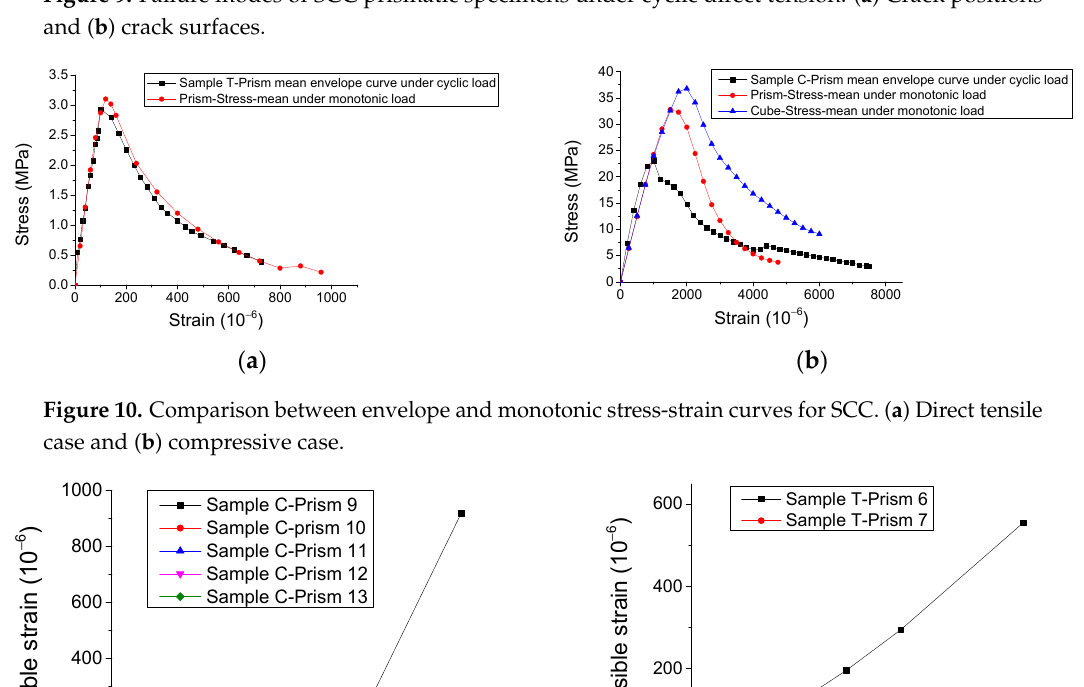
Figure 11. Experimental results of relationship of irreversible strain—unloading strain. ( a ) Compressive case and ( b ) direct tensile case.